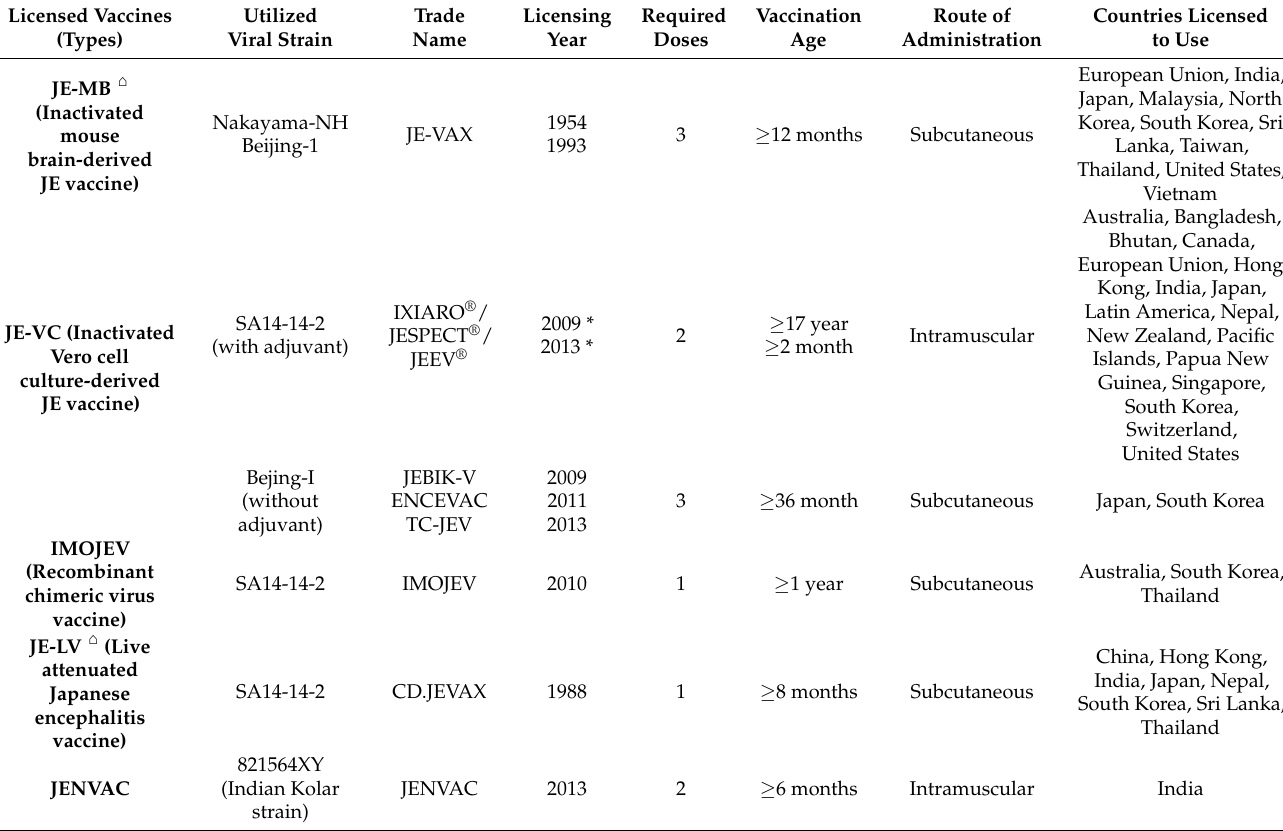
Table 2. Licensed JEV vaccines so far.